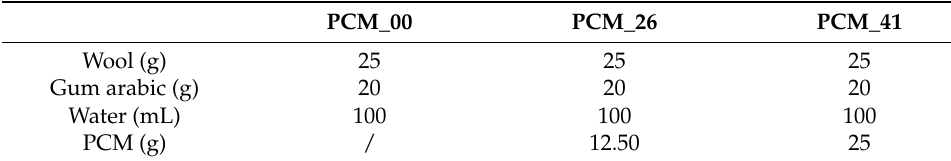
Figure 5. From left to right: PCM_00, PCM_26, PCM_41. Table 1. Quantity of materials used in the specimens.